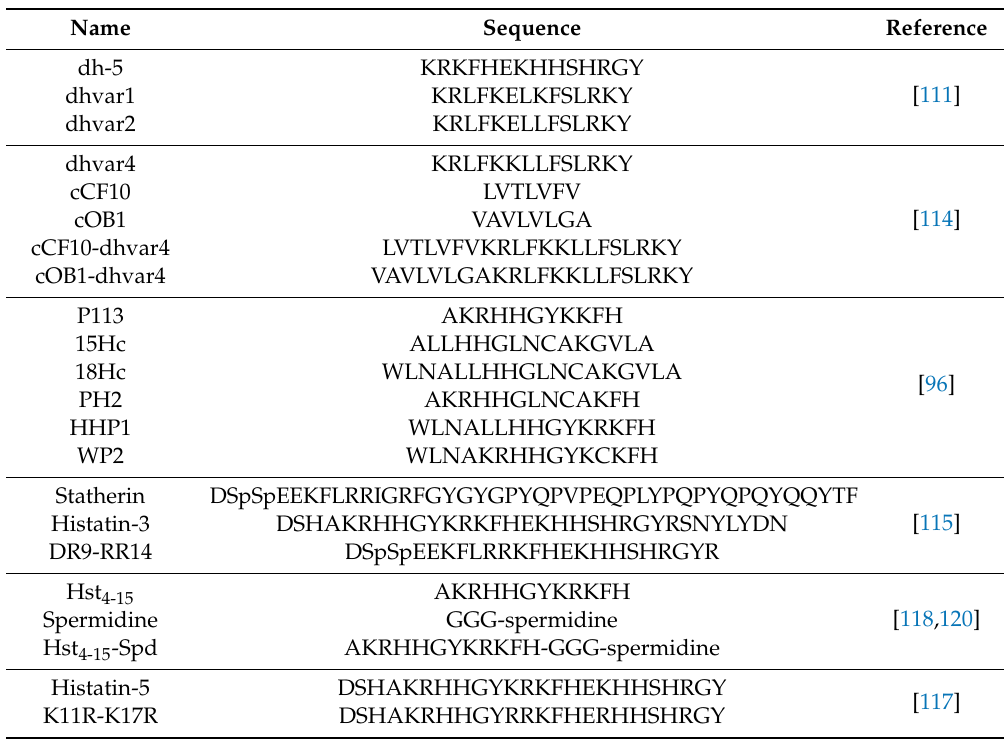
Table 1. Name and amino acid sequence for the analogues and hybrids peptides based on Histatin-5 primary